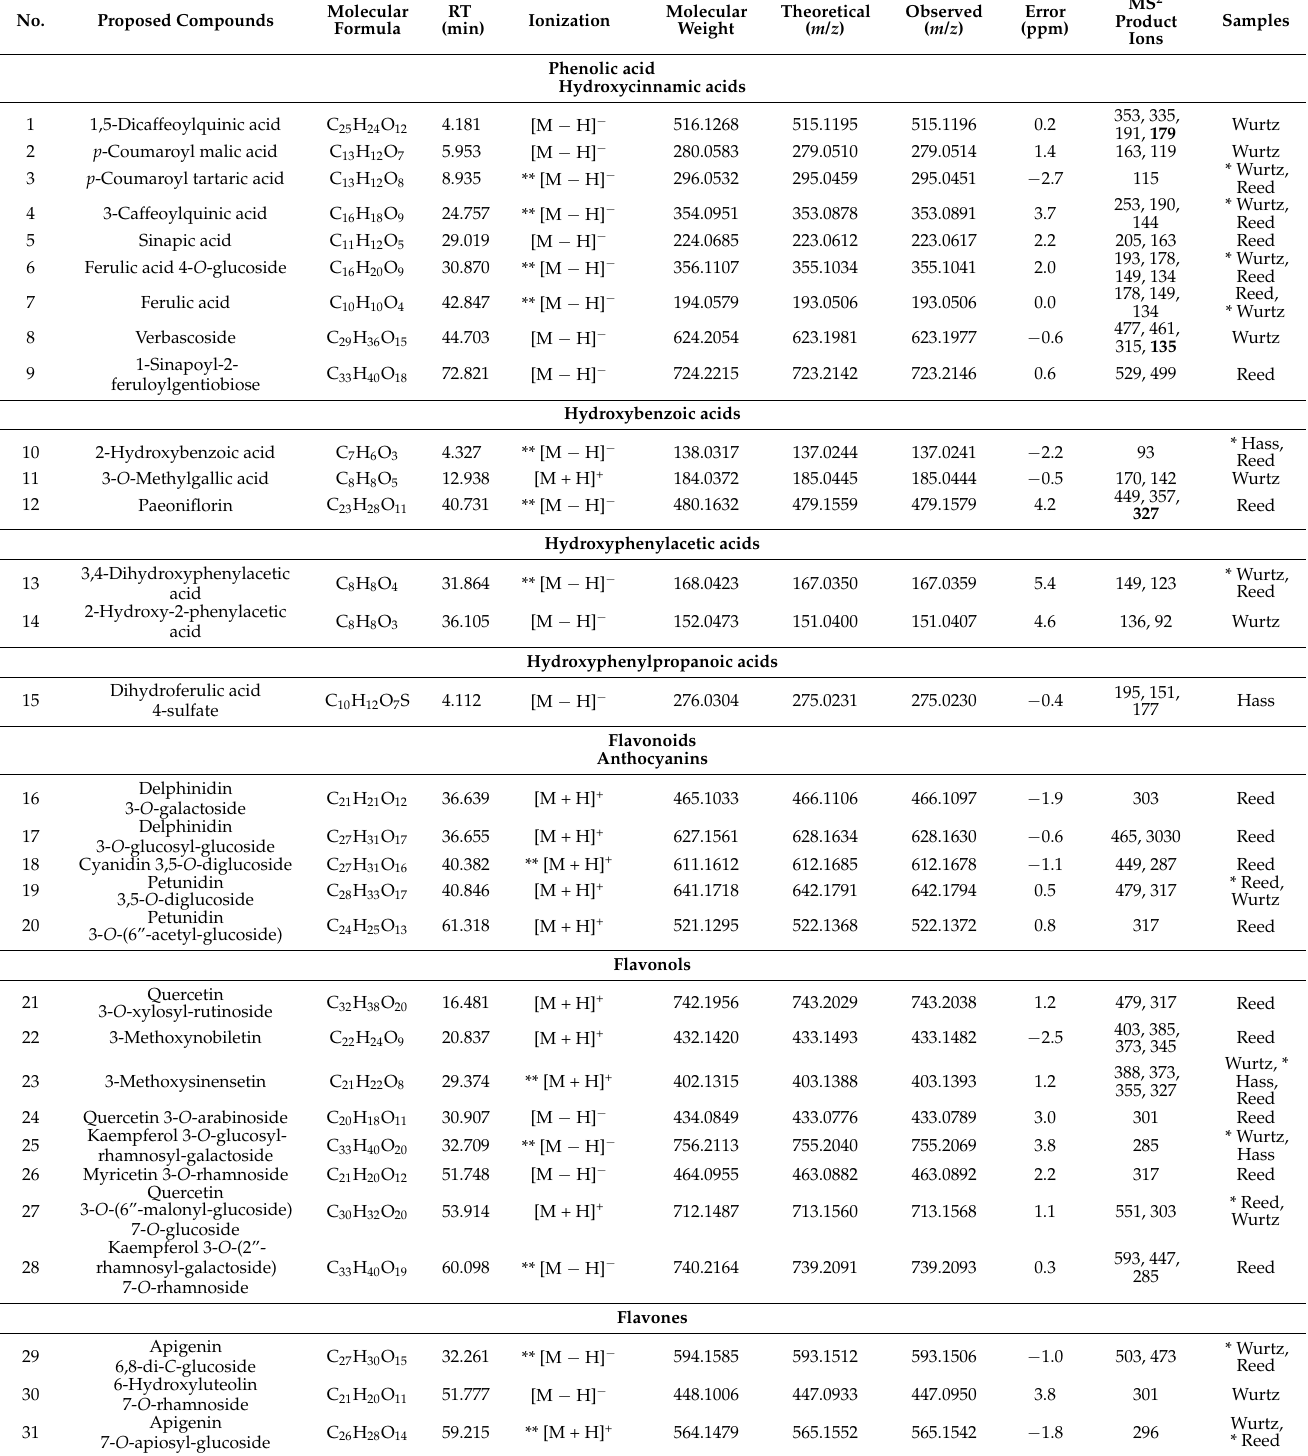
Table 2. Characterization of phenolic compounds in rejected avocados by